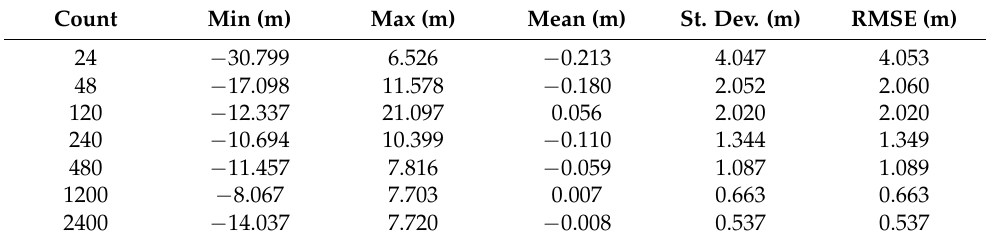
Table 2. Statistical terms of the residuals between each Ordinary Kriging model and initial dataset values.